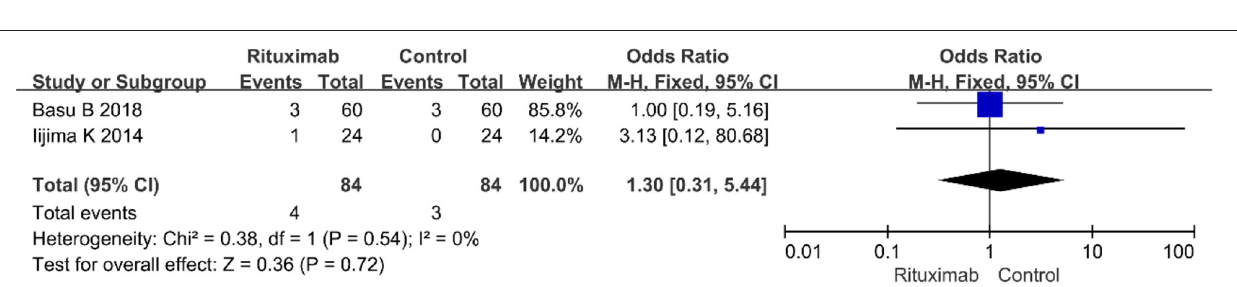
FIGURE 9 | Forest plot showing a meta-analysis of infusion reactions between rituximab treatment group and control group.